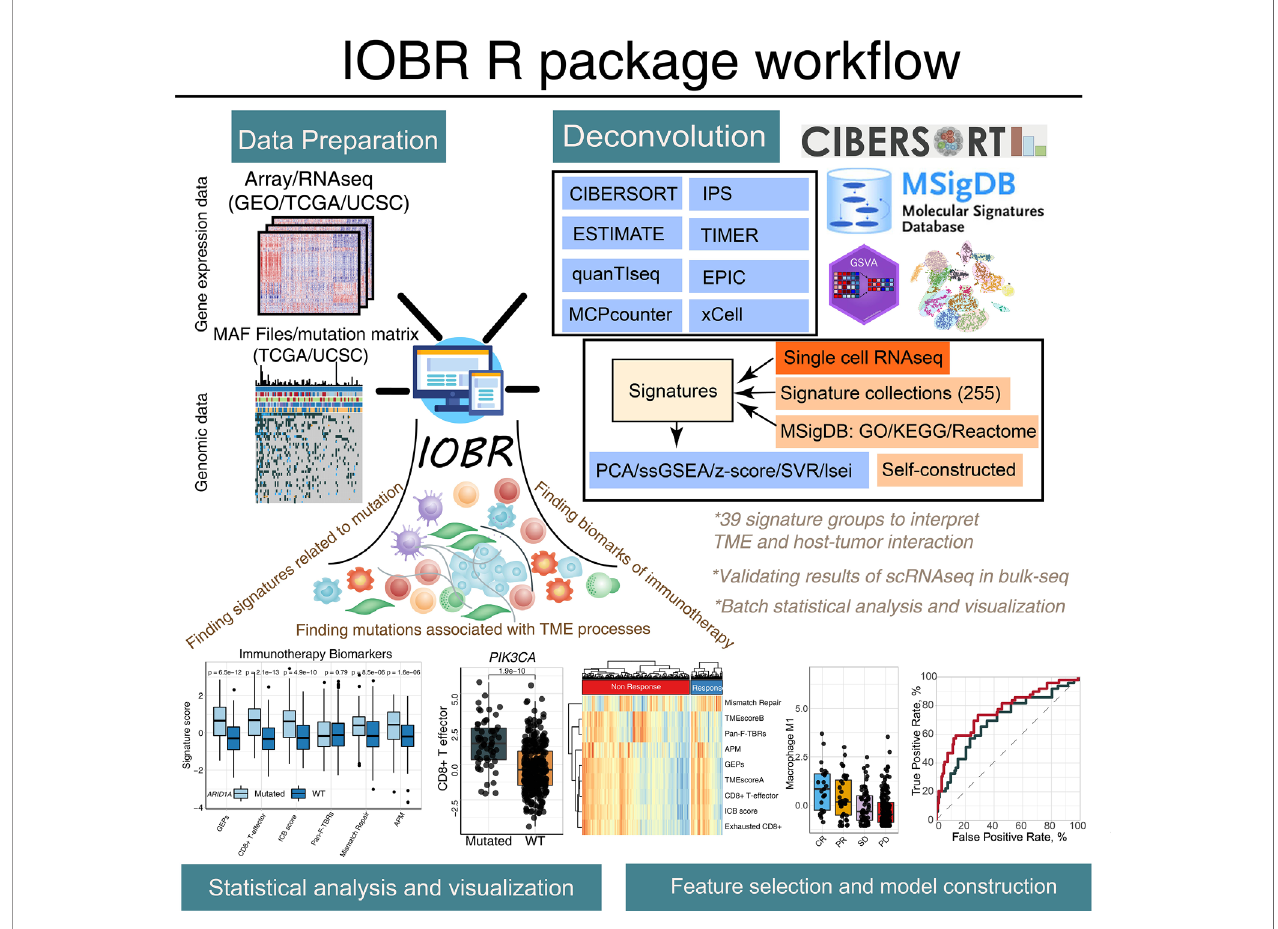
FIGURE 1 | The graphical abstract outlines the work fl ow of the IOBR package. The IOBR R package contains corresponding data preparation, multiple deconvolution algorithms for the decoded signature estimation, TME contexture, batch statistical analyses and visualization, as well as feature selection and model